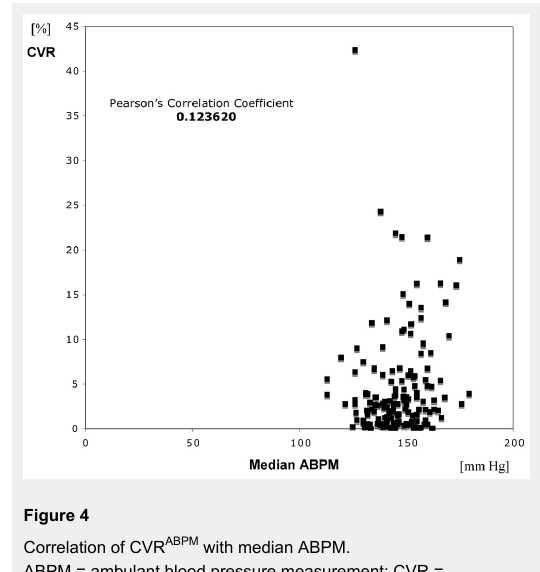
Correlation of CVR ABPM with median ABPM. ABPM = ambulant blood pressure measurement; CVR = cardiovascular